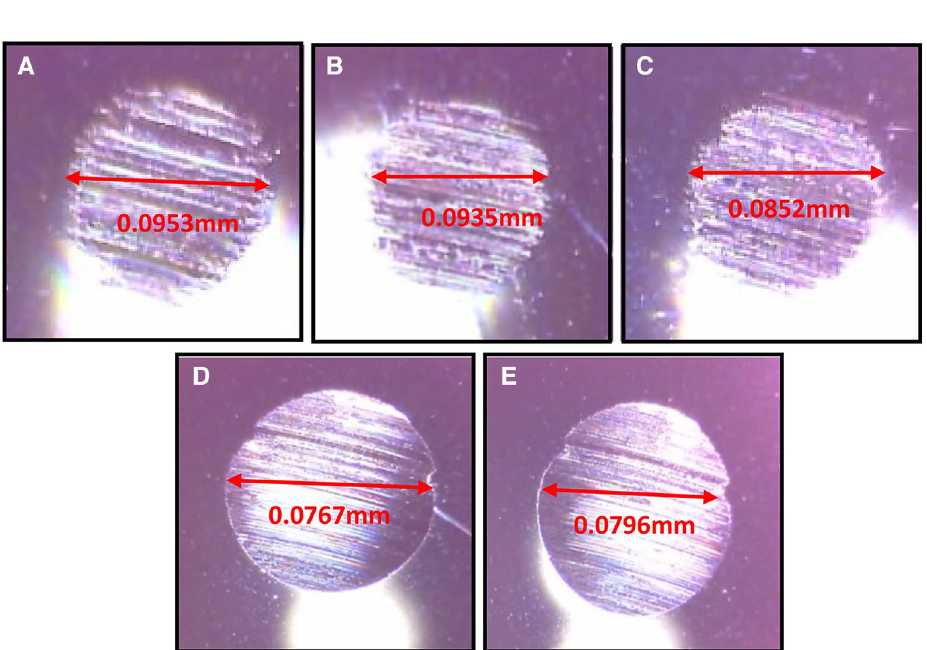
Figure 8. Images of steel balls after tribological analysis using base oil ( A ), 0.1 wt% MoS 2 ( B ) and 0.05 wt%